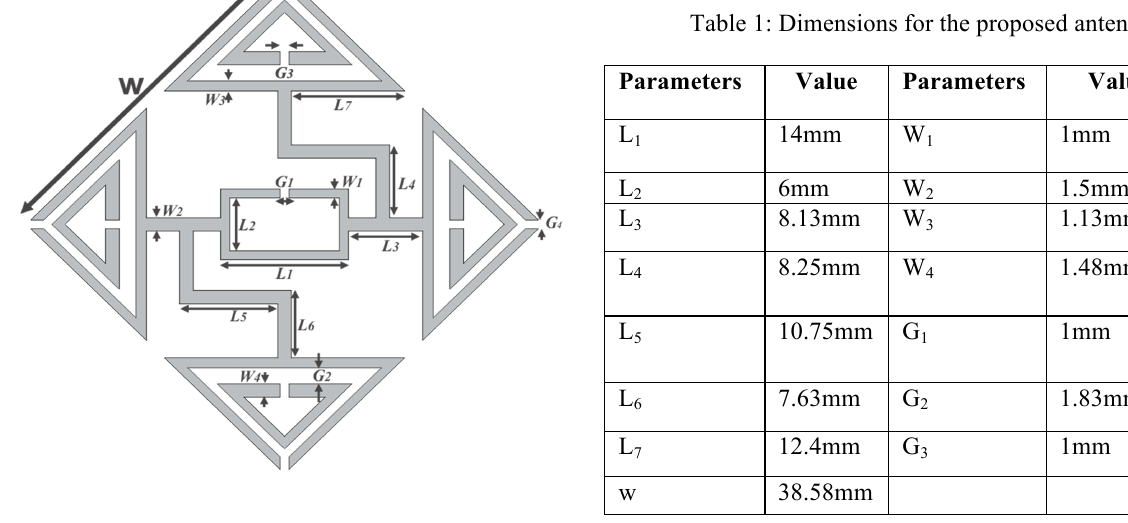
Figure 1: Geometrical structure of the proposed RFID tag